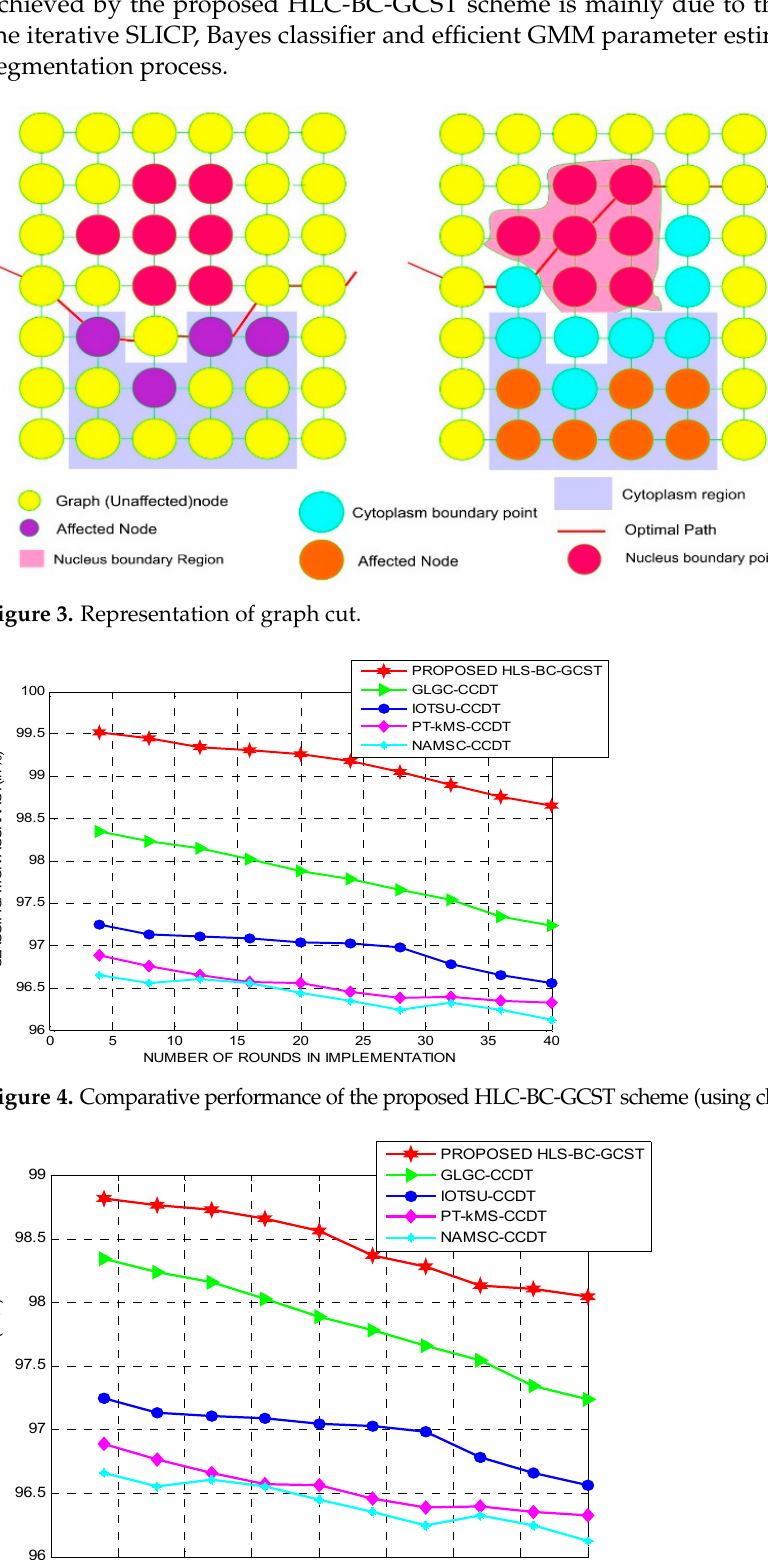
Figure 5. Comparative performance of the proposed HLC-BC-GCST scheme (using sensitivity).